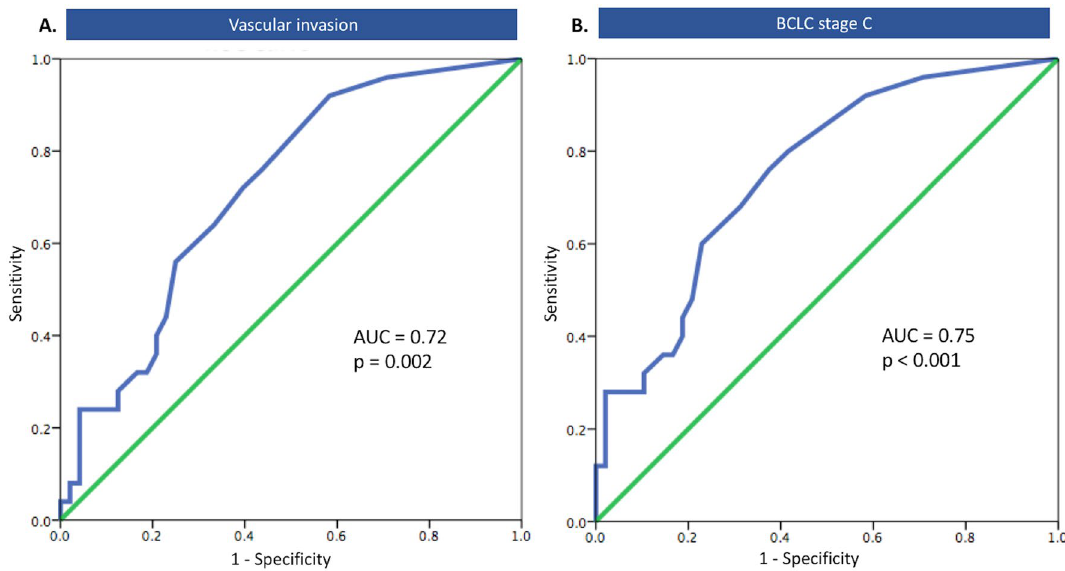
Figure 2. The AUROC curve of peripheral CTCs for prediction of vascular invasion ( A ), and BCLC stage C ( B